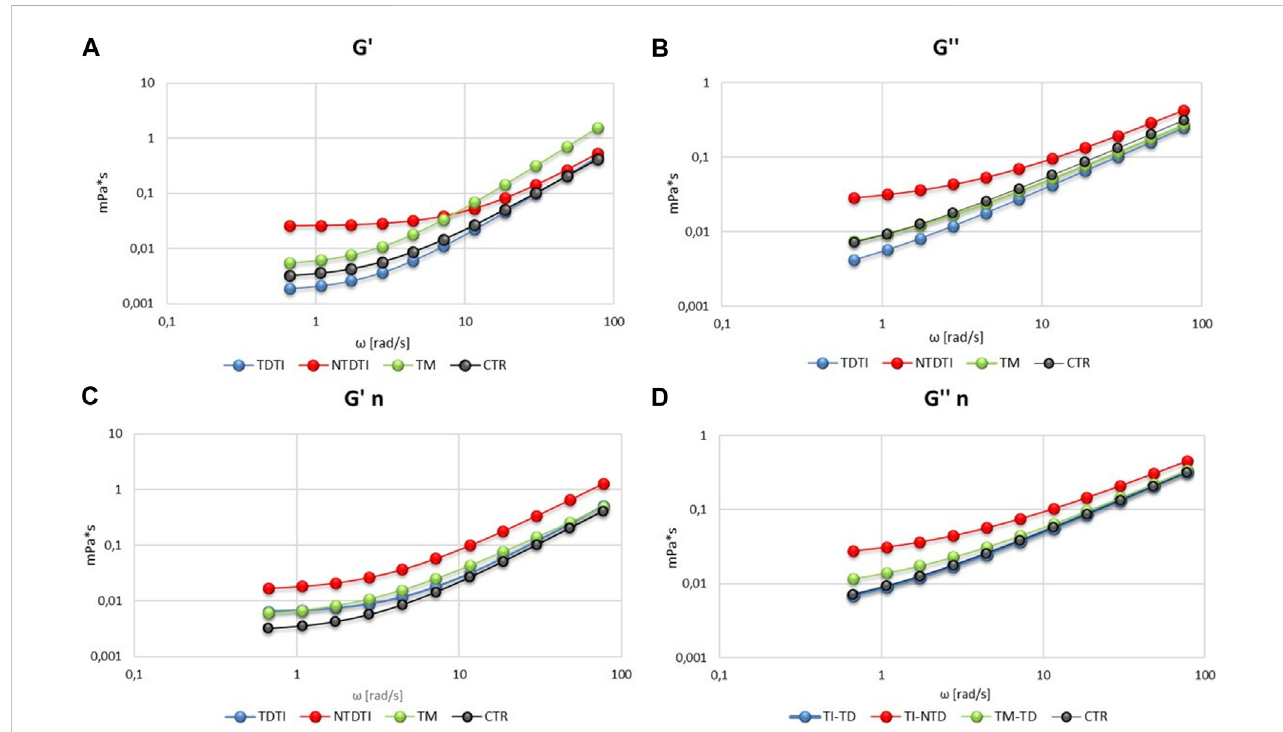
FIGURE 3 Viscoelastic pro fi les (storage modulus G ’ and loss modulus G ’’ ) of blood from thalassemia groups and healthy subjects at native (A,B) and normalized (n) hematocrit (C,D) . TM: thalassemia major; TDTI: transfusion-dependent thalassemia intermedia; NTDTI: non-transfusion-dependent thalassemia intermedia.